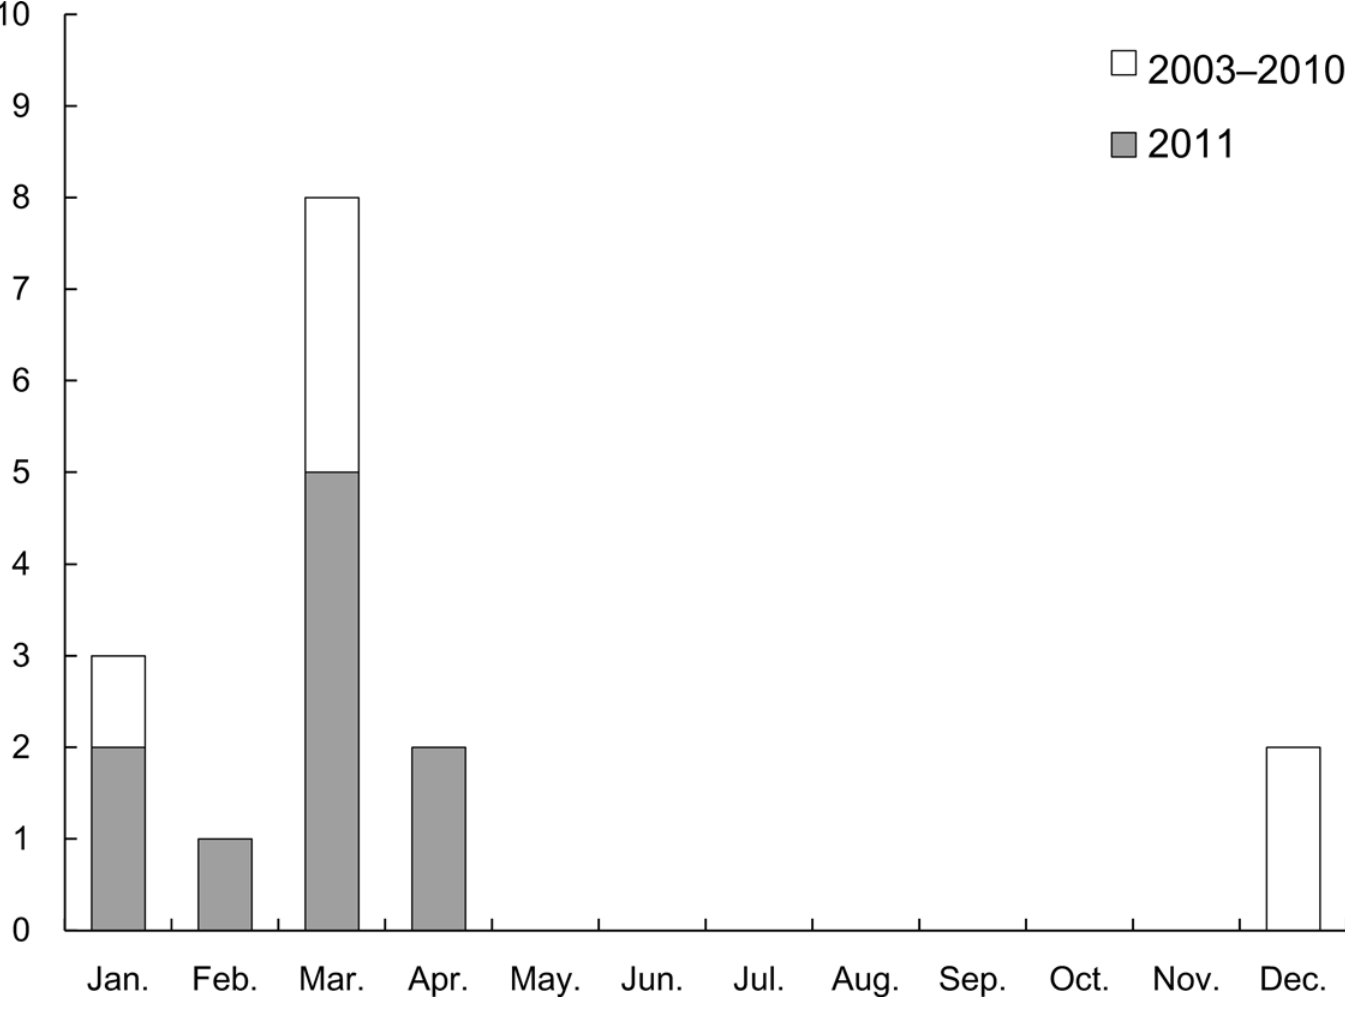
Fig 1. Number of cases with lung injury from one hospital in